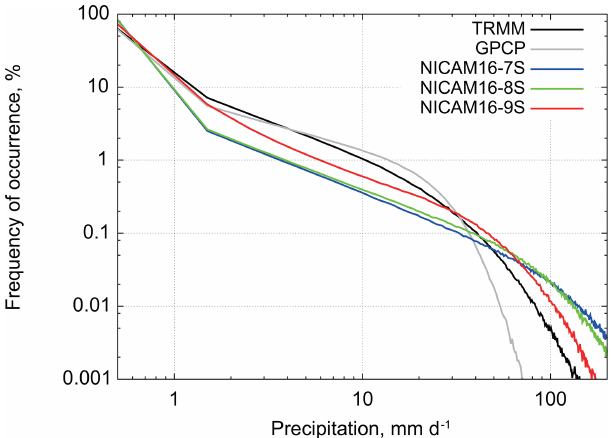
Figure 17. Frequency of occurrence (%) of daily mean precipitation binned with an interval of 1mmd − 1 during 1 June 2004–31 May 2005 as averaged over 15 ◦ S–15 ◦ N. The GPCP and TRMM prod- ucts are shown with black and gray curves, respectively. The REF- FIX runs with NICAM16-7S, NICAM16-8S, and NICAM16-9S are shown with blue, green, and red curves, respectively. The data were regridded at 1 ◦ in longitude and latitude before the